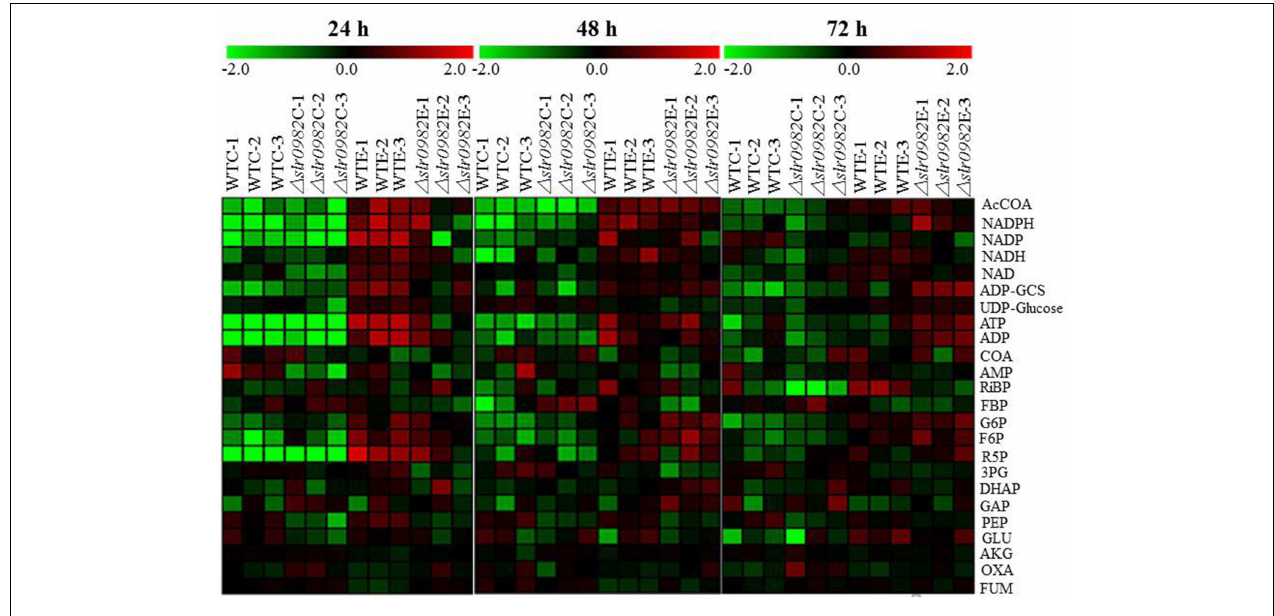
FIGURE 3 | Heat map analysis of LC-MS metabolomics. The row displays metabolite and the column represents the samples. Metabolites significantly decreased were displayed in green, while metabolites significantly increased were displayed in red. The brightness of each color